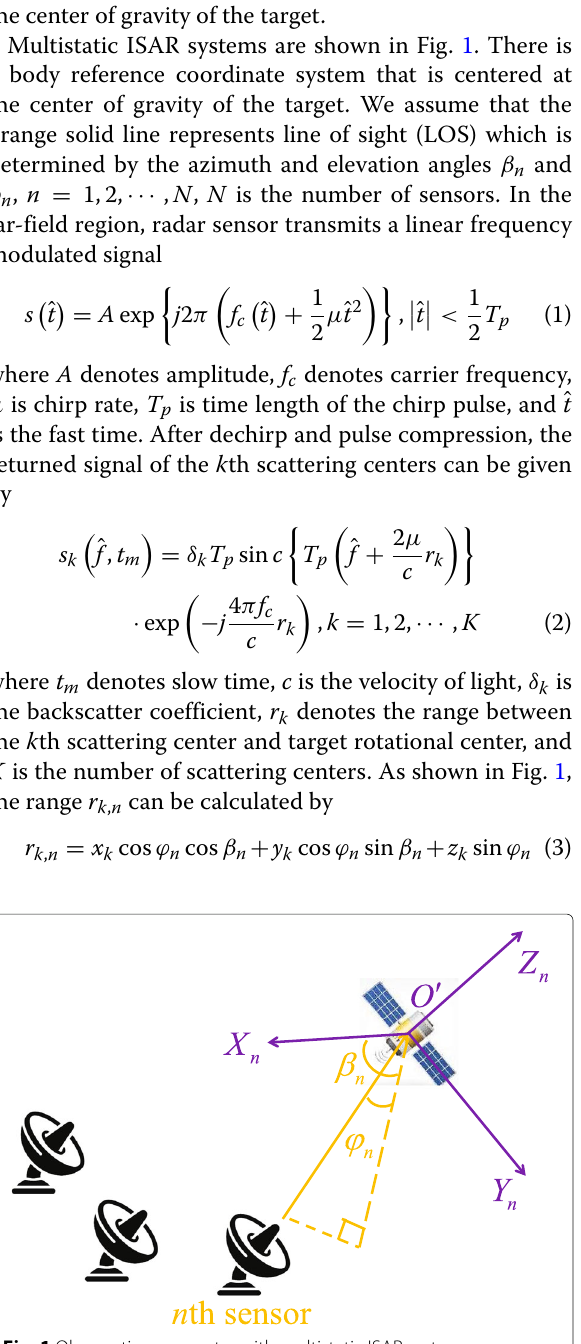
Fig. 1 Observation geometry with multistatic ISAR